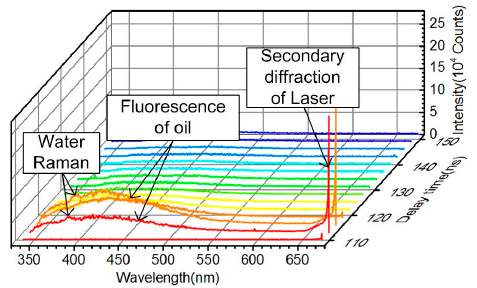
Figure 4. Typical returned signal of gasoline (G) taken by the laser remote sensing system.